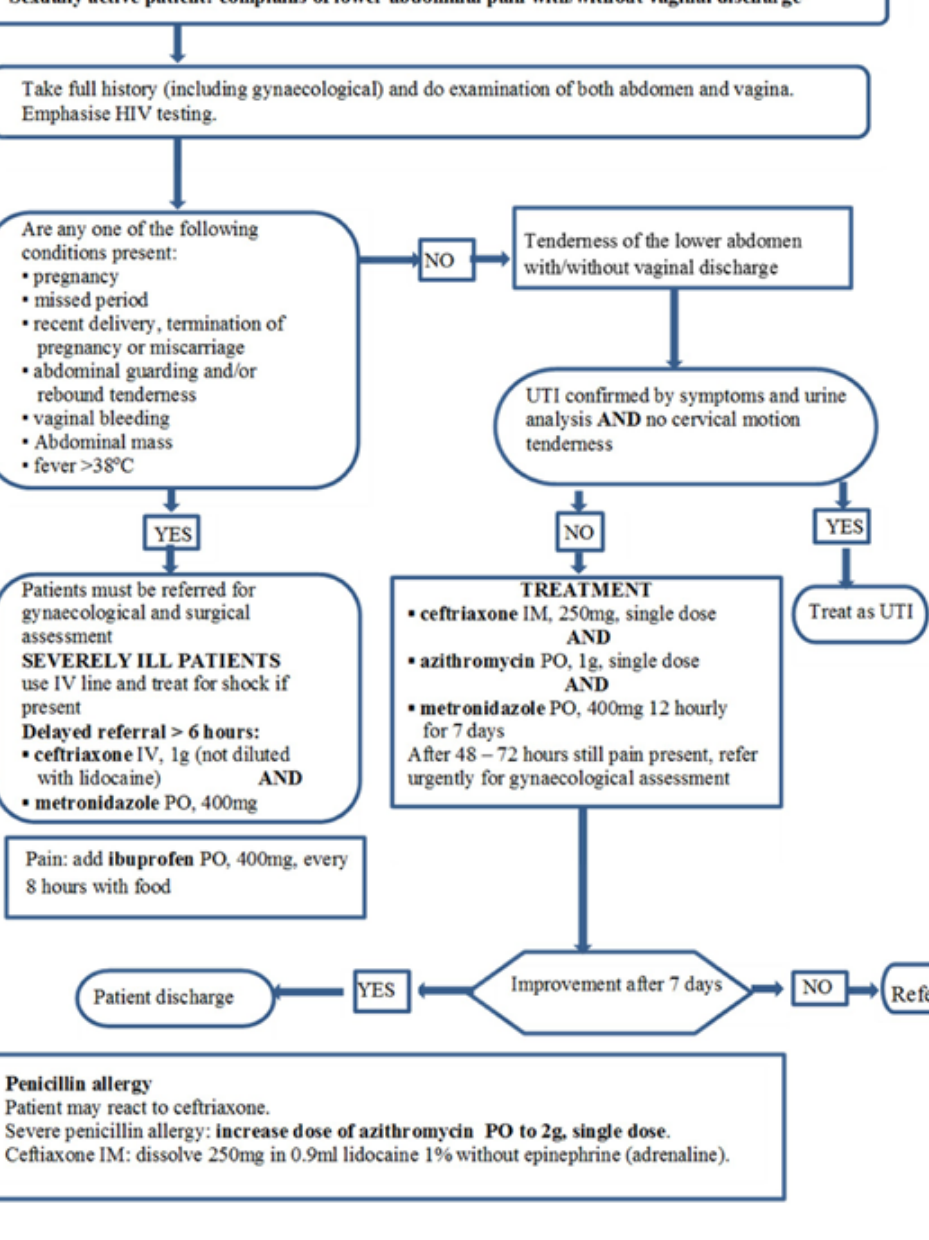
Figure 2: Flowchart of syndromic treatment of Lower Abdominal Pain. (adapted from the revised LAP flowchart of the Primary Health Care Standard Treatment Guidelines and Essential Drugs List, 2015)